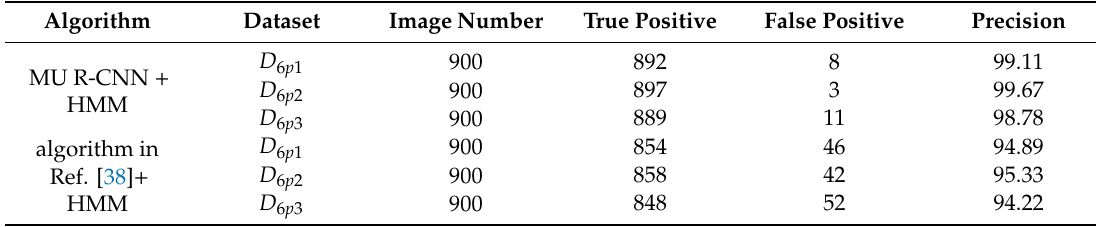
Table 7. Comparison of tracking e ff ects between HMM 0 and HMM 1 .